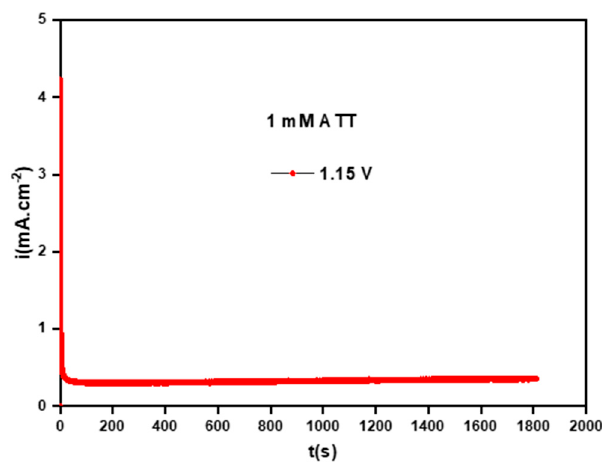
Figure 2. Chronoamperometry of a 1 mM ATT solution carried out at 1.15 V/Ag-AgCl on a brass alloy in pure methanol containing 0.1 M KOH.